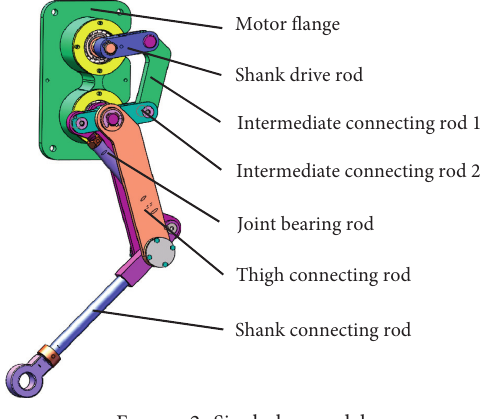
Figure 2: Single-leg